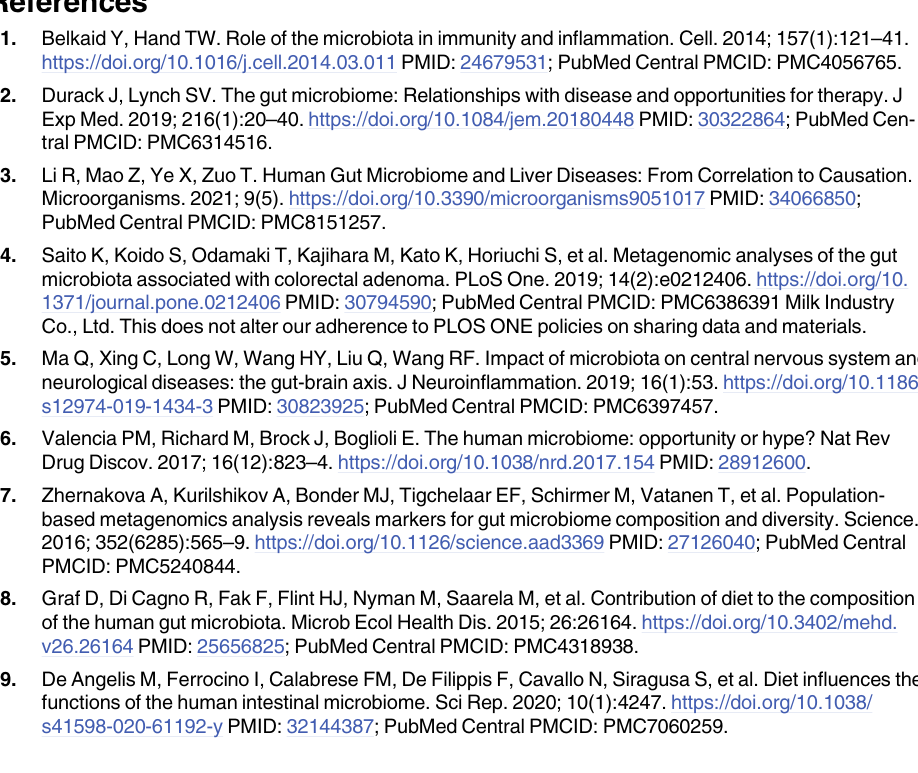
S1 Table. Comparison of gut community richness and diversity between adults and chil- dren, and normal and obese groups. Values are presented as p -values. Bold letters indicate significant differences (Mann-Whitney U-test, p < 0.05). S1 Fig. Comparison of relative abundance of Bacteroidetes and Firmicutes in Ct and Qia kits for the same sample. A. Bacteroidetes . B. Firmicutes . S2 Fig. Relative abundance of subgroup microbiome at genus level. A. Normal weight group: adults vs. children, left: Ct kit, right: Qia kit. B. Obese group: adults vs. children, left: Ct kit, right: Qia